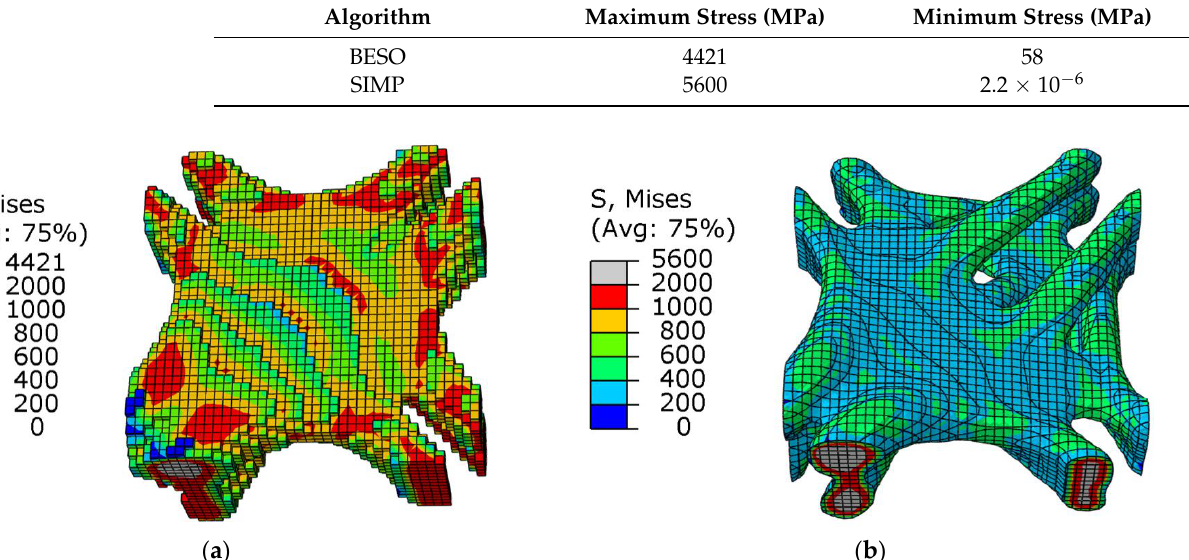
Table 3. Comparison of optimization results of combined working conditions.